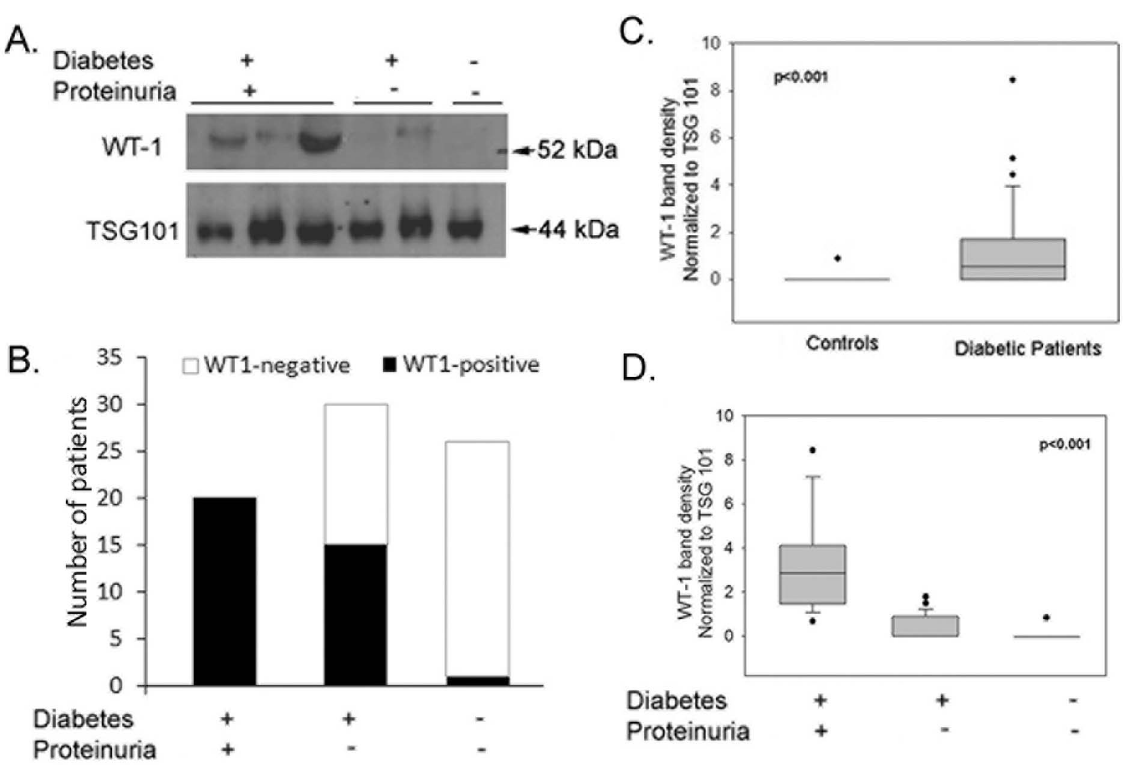
Figure 1. Detection of WT1 protein in urinary exosomes of diabetic patients with or without proteinuria. A) Representative immunoblots for WT1 and TSG101 proteins in urinary exosome samples from, type 1 diabetic patients with or without proteinuria and healthy controls. Exosomal protein obtained from same urine volume was loaded for all the samples. B) Frequency of WT1 expression in urinary exosomes from diabetic patients with or without proteinuria and healthy controls. All subjects were positive for TSG101 protein, an exosomal marker (data not shown). Densitometry analysis of WT1 bands in: C) Type-1 diabetic patients, using Mann-Whitney U test, and D) Proteinuria and Non-Proteinuria groups, using ANOVA rank test. The boxes indicate median and 25th and 75th percentiles; Outliers are indicated by closed dots. p , 0.05 was considered significant.